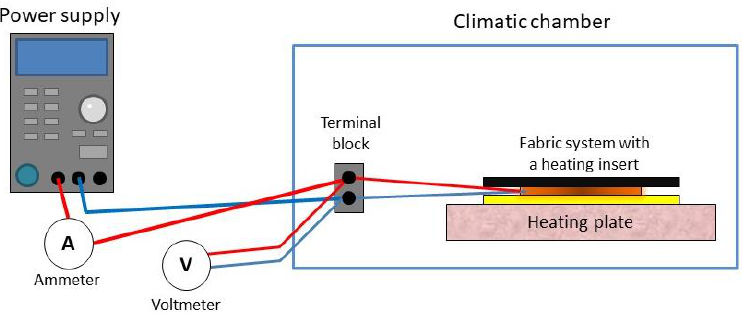
Figure 4. Diagram of the measuring system for testing the thermal resistance of the system of materials with a heating insert.